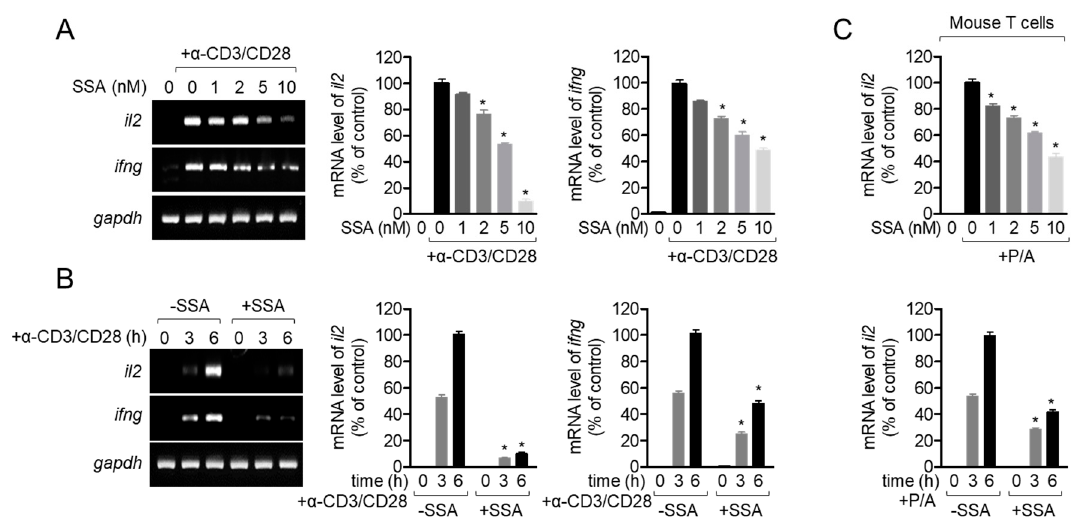
Figure 6. Treatment with 10 nM salinosporamide A inhibits T-cell activity following TCR-mediated and PMA / A23187 stimulation. ( A ) Jurkat T cells pre-treated with the indicated concentration of salinosporamide A (0–10 nM) for 1 h were stimulated with anti-CD3 (20 µ g / mL) / CD28 (7 µ g / mL) antibodies for 6 h. mRNA levels of il2 and ifng were measured by conventional and quantitative PCR. ( B ) Jurkat T cells pre-treated with the 10 nM salinosporamide A for 1 h were stimulated with anti-CD3 (20 µ g / mL) / CD28 (7 µ g / mL) antibodies for the indicated time (0–6 h). mRNA levels of il2 and ifng were measured by conventional and quantitative PCR. ( C ) Mouse T cells pre-treated with the indicated concentration of salinosporamide A (0–10 nM) or 10 nM salinosporamide A for 1 h were stimulated with PMA (100 nM) / A23187 (1 µ M) for 6 h or indicated time (0–6 h). After cells were harvested, the mRNA level of il2 was determined by quantitative PCR. The mean value of three experiments ± SEM is presented. * p < 0.05 between control cells.